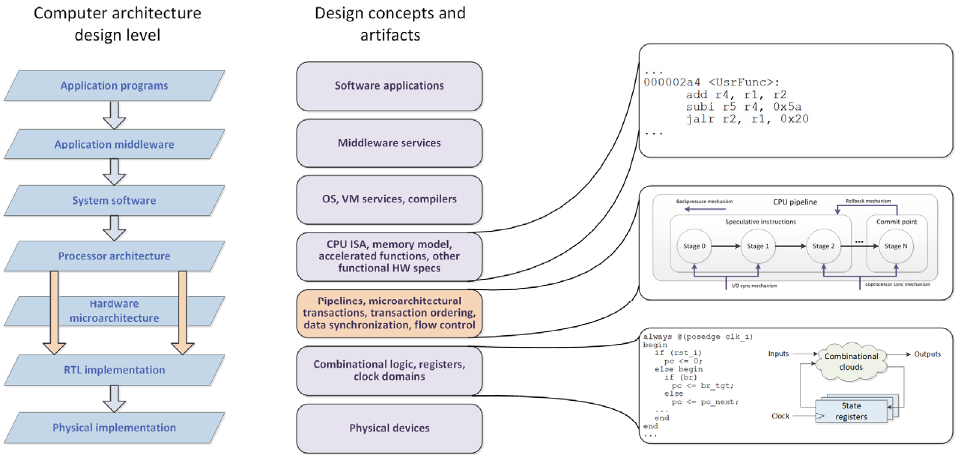
Figure 1. “Microarchitectural” design level being implicit (“leaped”) in computer systems design Figure flows.